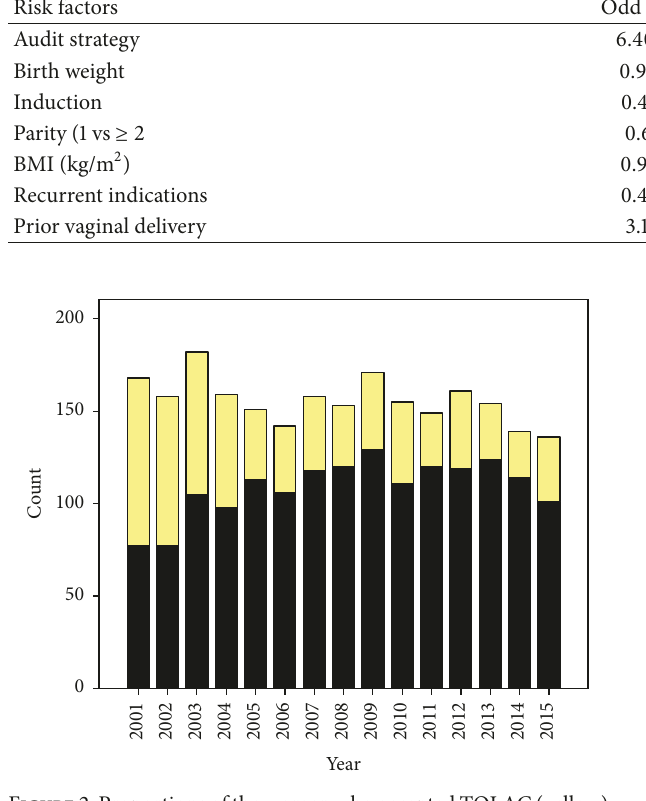
failure rate included large fetuses, in concordance with late gestational age; increased maternal BMI; induction of labor; and history of recurring indications, which were mostly consistent with previous